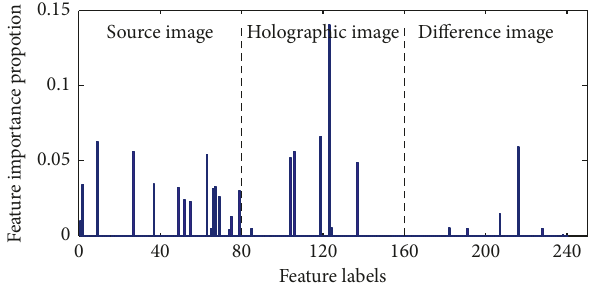
Figure 8: Feature importance of 2.5D sound field model.